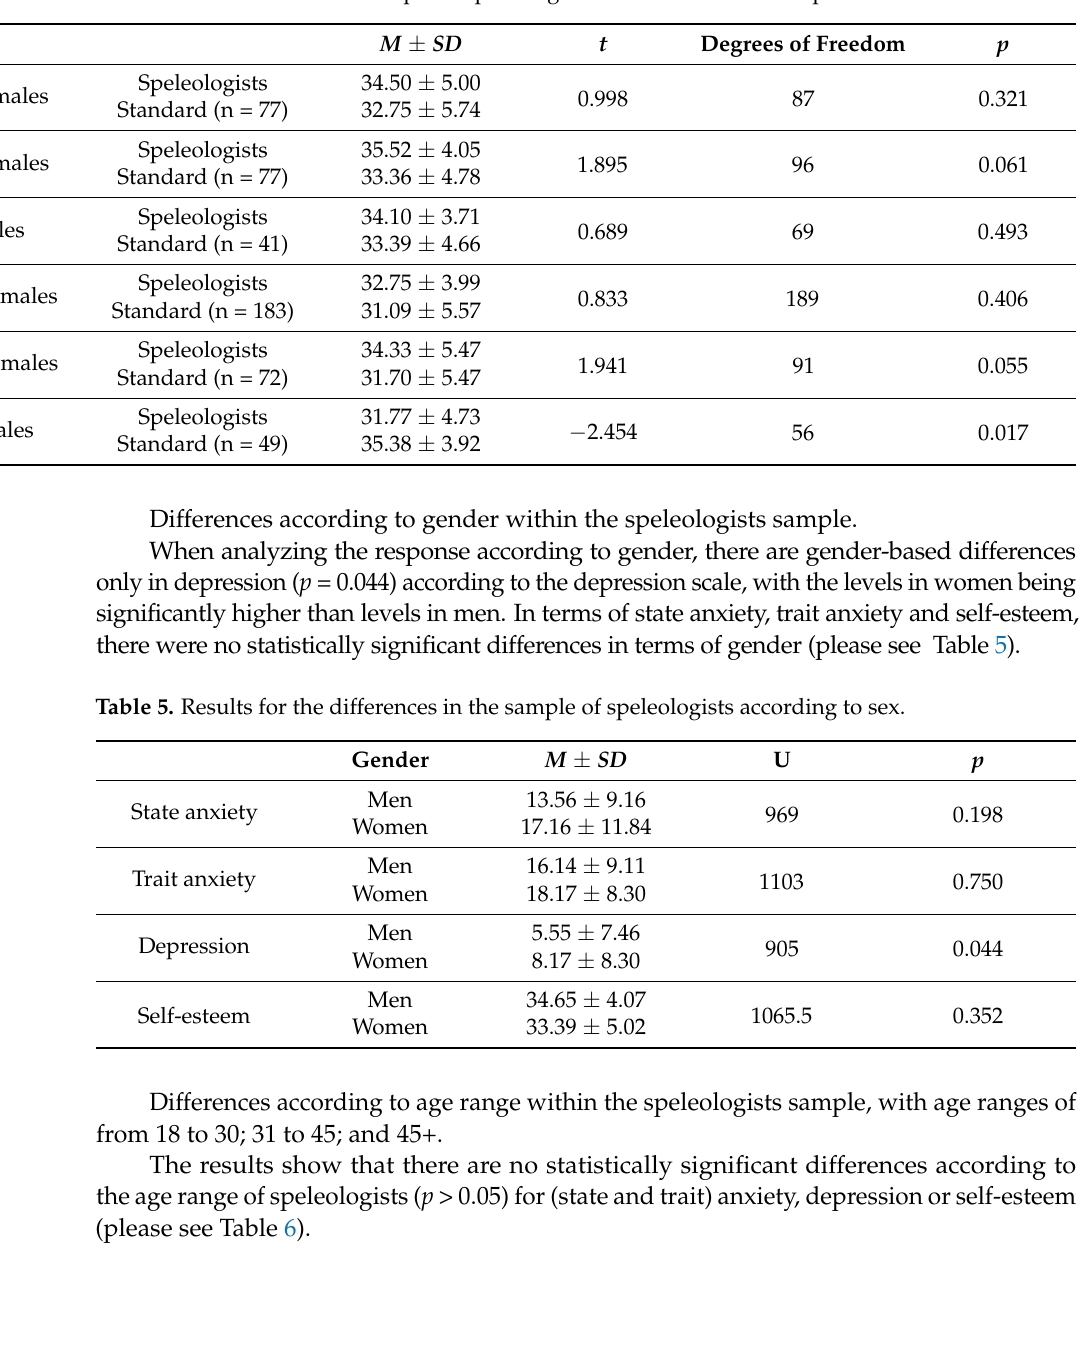
Table 4. Values for self-esteem in the sample of speleologists and the standard sample.